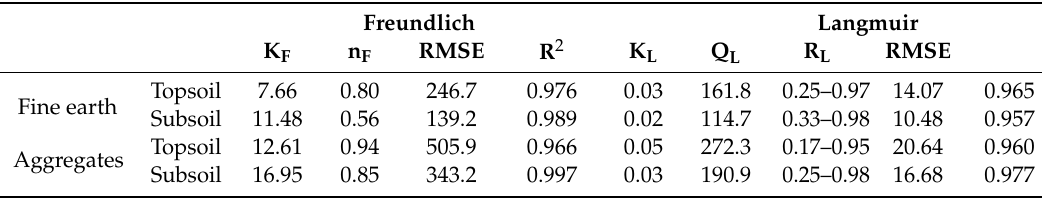
Table 3. Sorption Freundlich and Langmuir isotherm